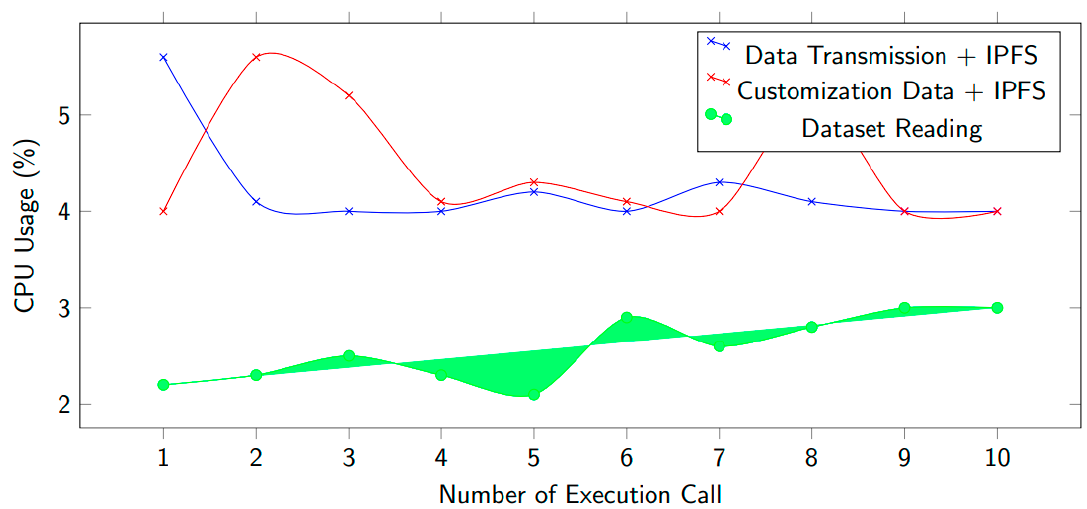
Figure 12. CPU time spent performing calculations.